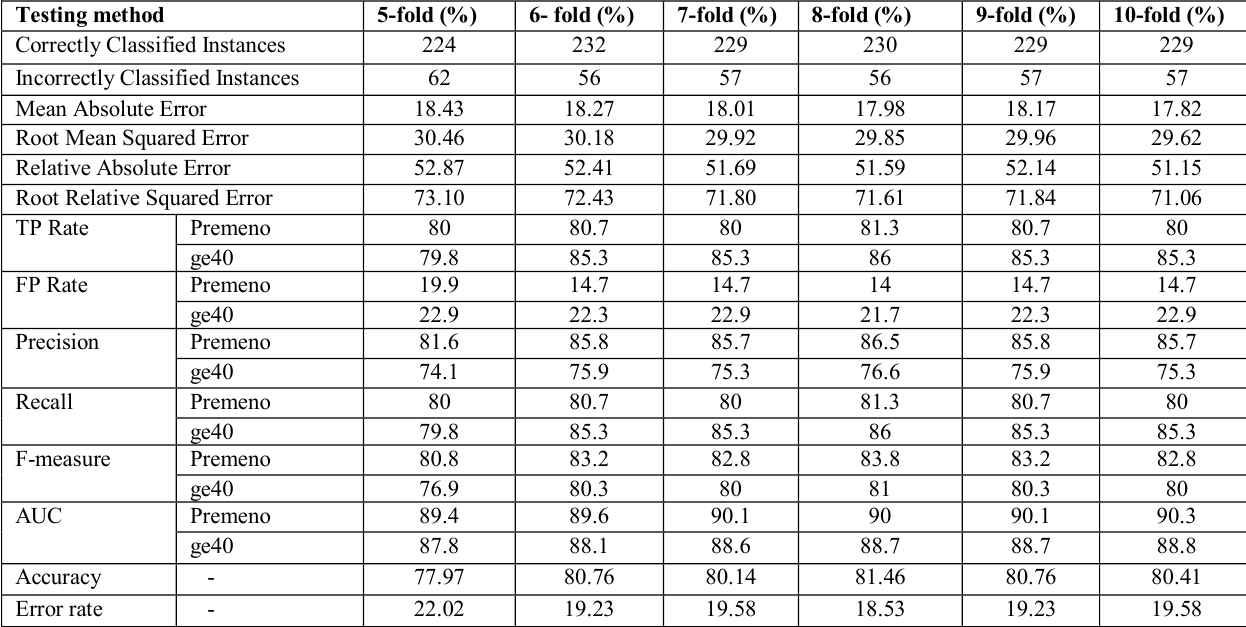
Table 6. Performance metrics of Naïve Bayes using method II